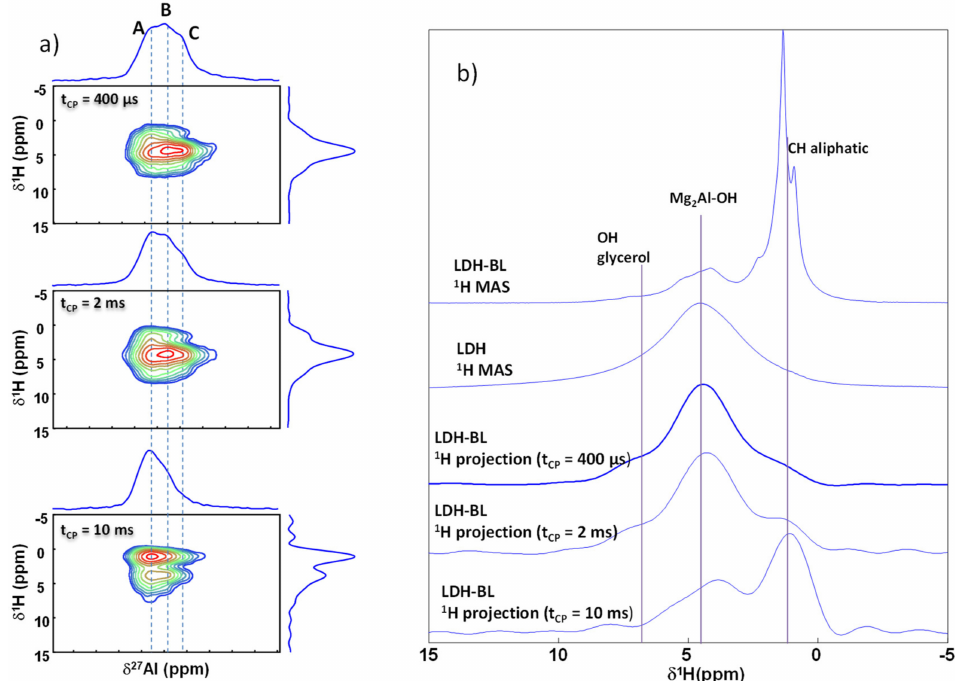
Figure 8. ( a ) Two dimensional 1 H- 27 Al CP MAS spectra of LDH-BL recorded at various contact times (t CP = 400 µ s, 2 and 10 ms). ( b ) Comparison of the corresponding 2D 1 H projections with 1 H MAS spectra of LDH-BL and